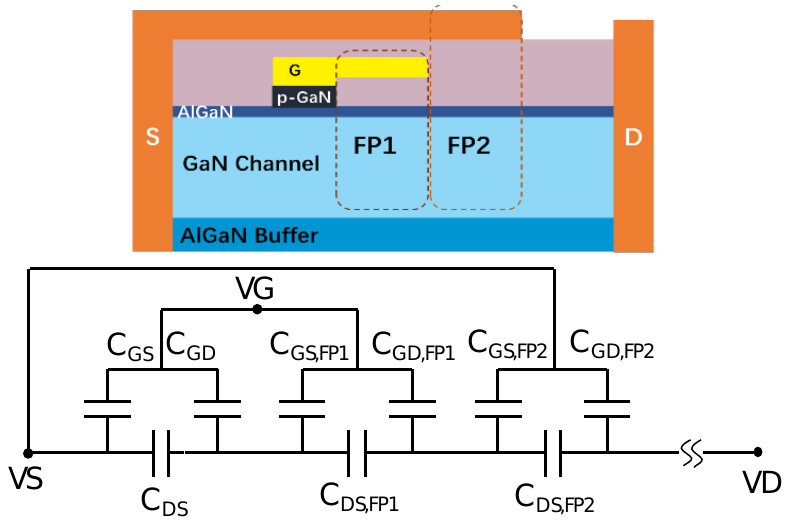
Figure 2. The equivalent circuit of the capacitance of field plates (FPs) of a p-GaN gate HEMT.